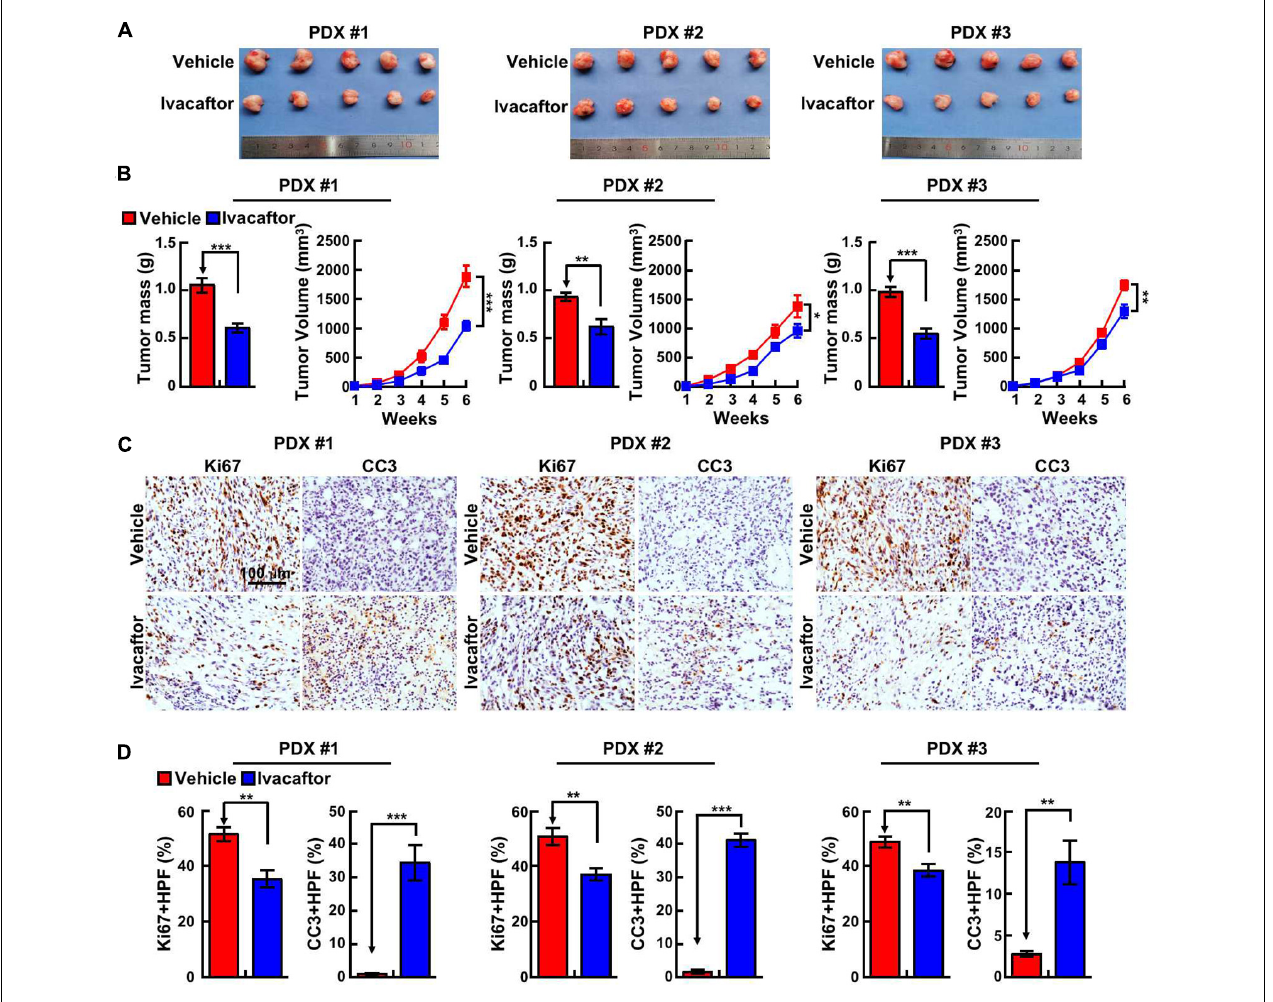
FIGURE 4 | Ivacaftor inhibits PDX tumor growth in vivo . (A) Representative images of PDX tumors derived from three independent GBM clinical specimens treated with ivacaftor or vehicle. (B) Tumor mass and volume of three xenograft tumors treated with 3 mg/kg ivacaftor or vehicle. (C,D) Representative images of immunohistochemical staining of Ki67 and CC3 in three PDX tumors. (D) Quantification data for (C) . Data are shown as means ± SEM, * P < 0.05; ** P < 0.01; *** P < 0.001; t